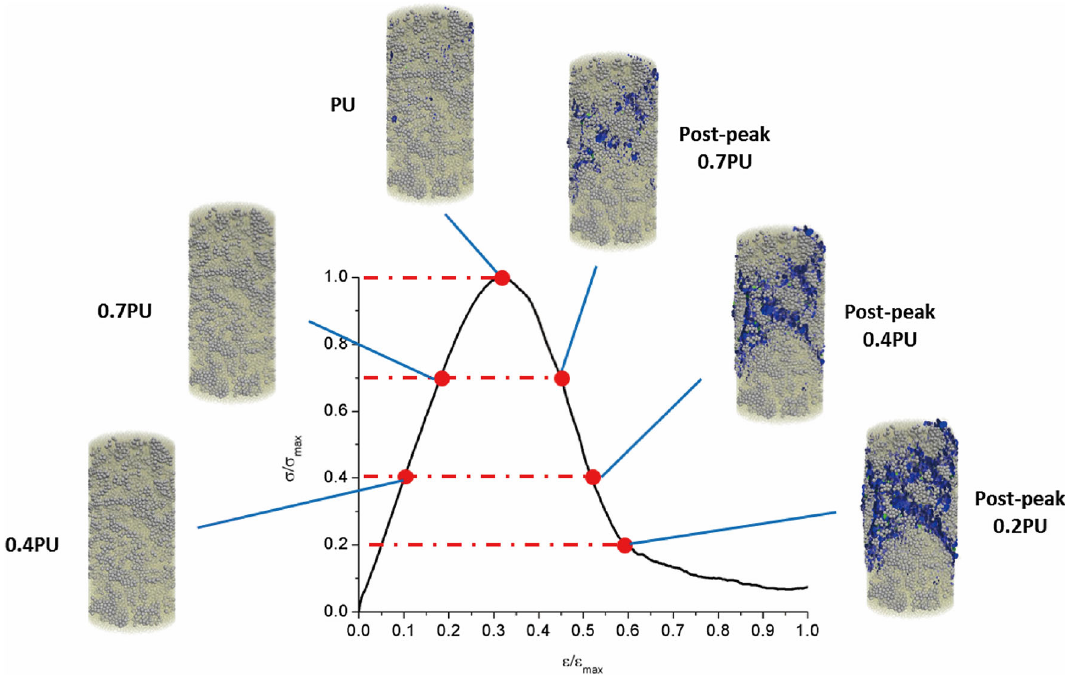
Fig. 15 Illustration of the loading and simulation stages